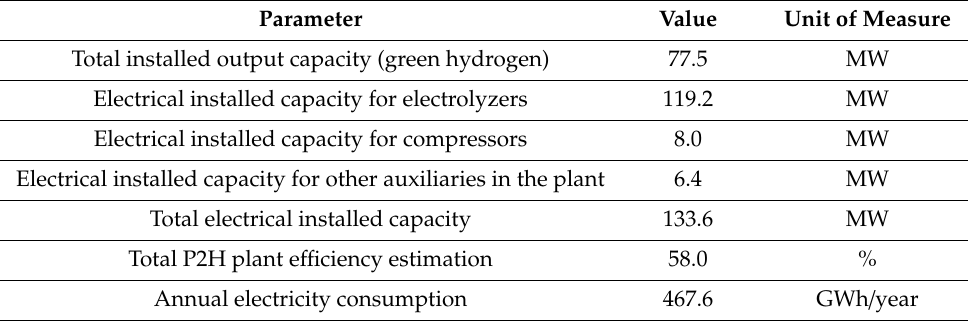
Table 9. Preliminary estimation of Italian P2H plants’ total